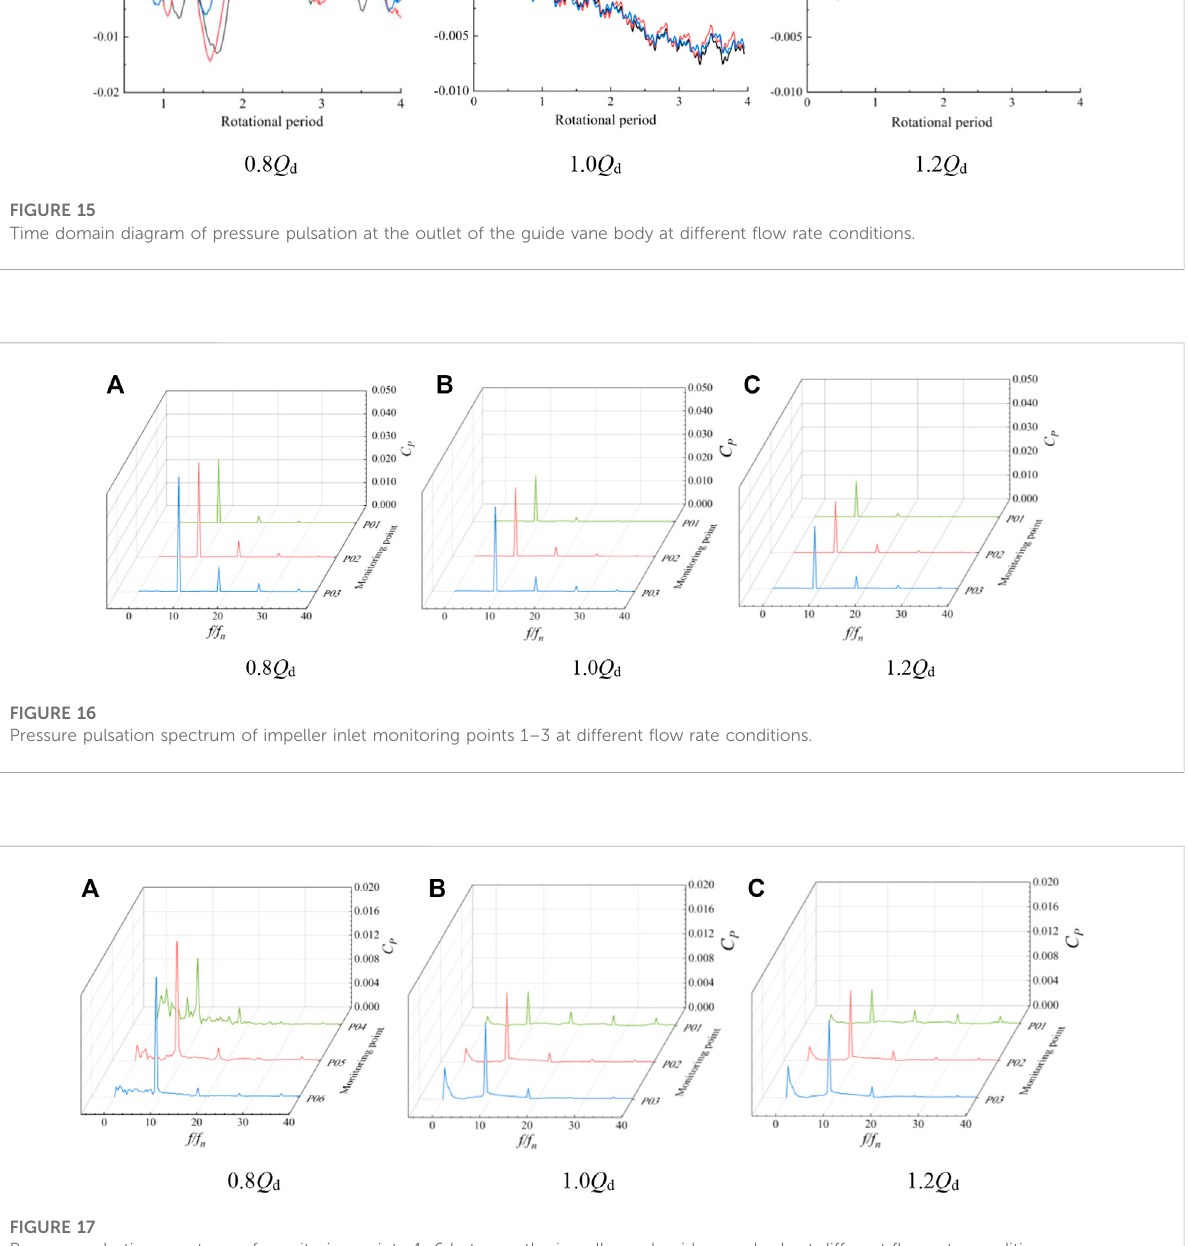
The frequency spectrum of pressure pulsation at monitoring points P01 – P03 of the impeller inlet under various fl ow rate conditions is shown in Figure 16. The pressure pulsation